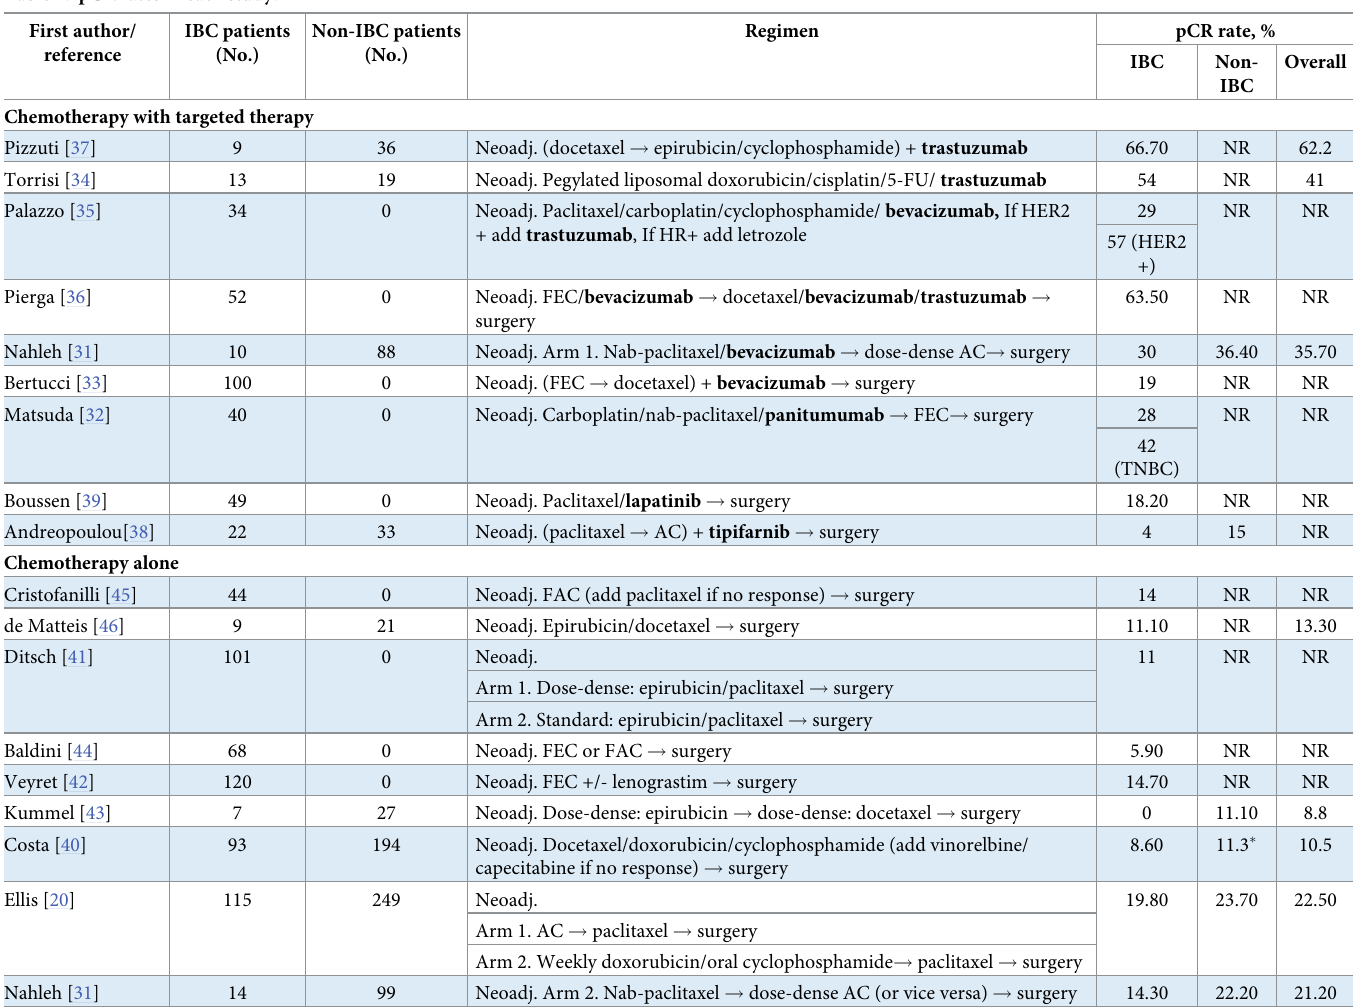
Table 2. pCR rates in each